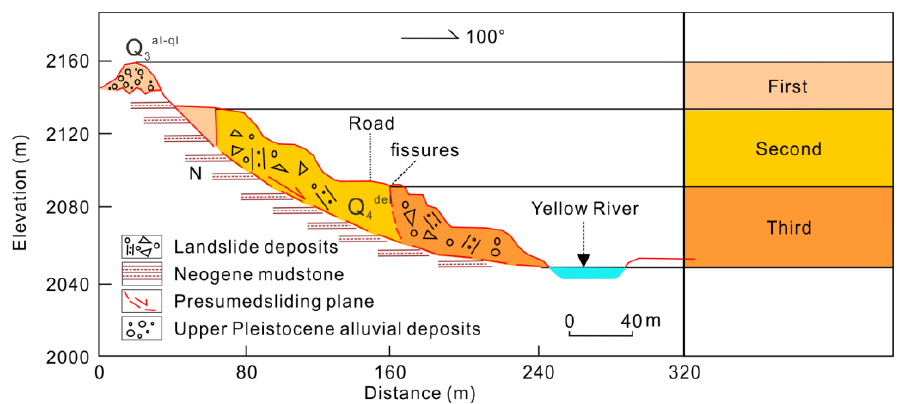
Figure 2. Longitudinal profile of the Simencun landslide (modified from Shi et al. [59]). A − A’ in Figure 1c is the Longitudinal section position.